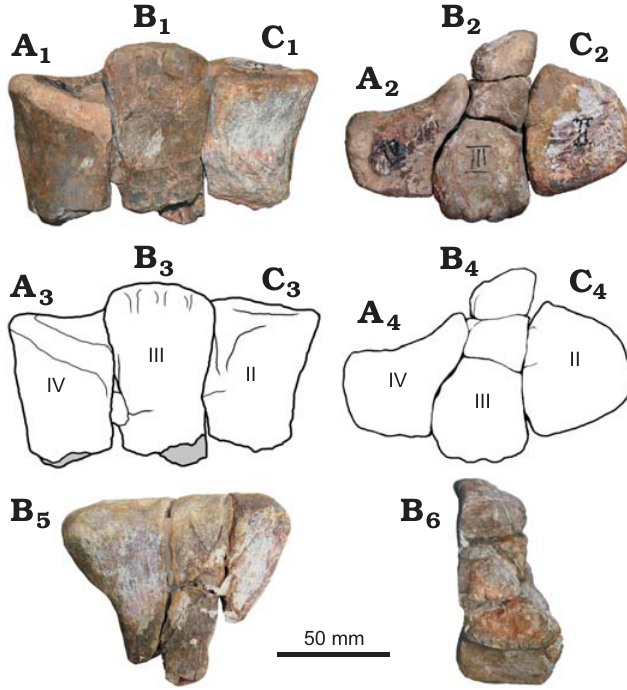
Fig. 12. Coelurosaurian theropod Phuwiangvenator yaemniyomi gen. et sp. nov. from the Early Creta ceous Sao Khua Formation of Phu Wiang, Khon Kaen Province, Thailand. SM-PW9B-44 ( A ), SM-PW9B-43 ( B ), SM-PW9B-42 ( C ); metatarsals in anterior (A 1 –C 1 ) and proximal (A 2 –C 2 ) views; line drawings in anterior (A 3 –C 3 ) and proximal (A 4 –C 4 ) views; metatarsal III in medial (B 5 ) and distal (B 6 ) views.